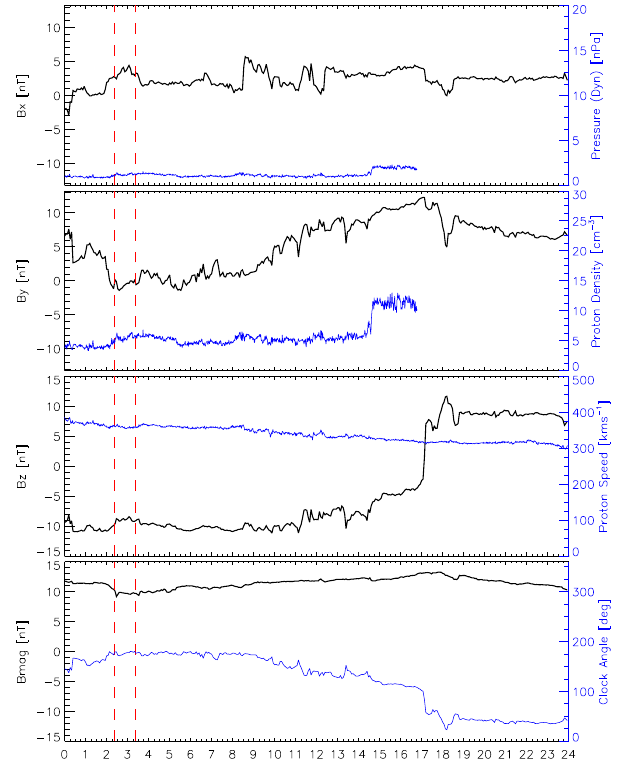
Fig. 3. ACE solar wind parameters showing several hours either side of 02:20–03:20